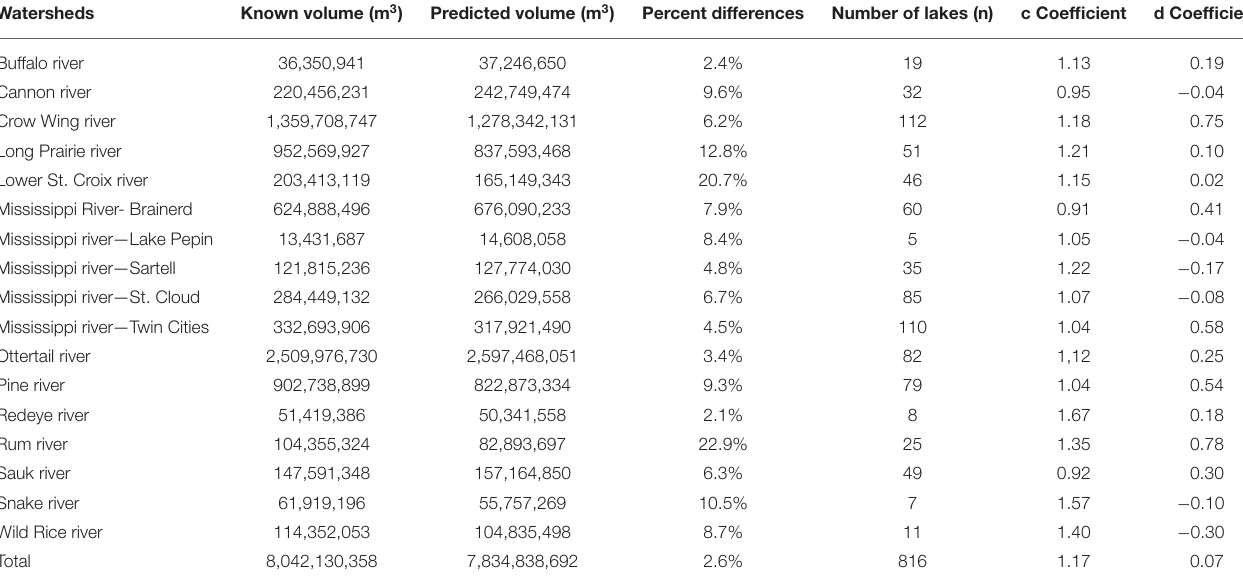
TABLE 5 | Total predicted volume by each watershed in study area based on Heathcote et al. (2015) model.